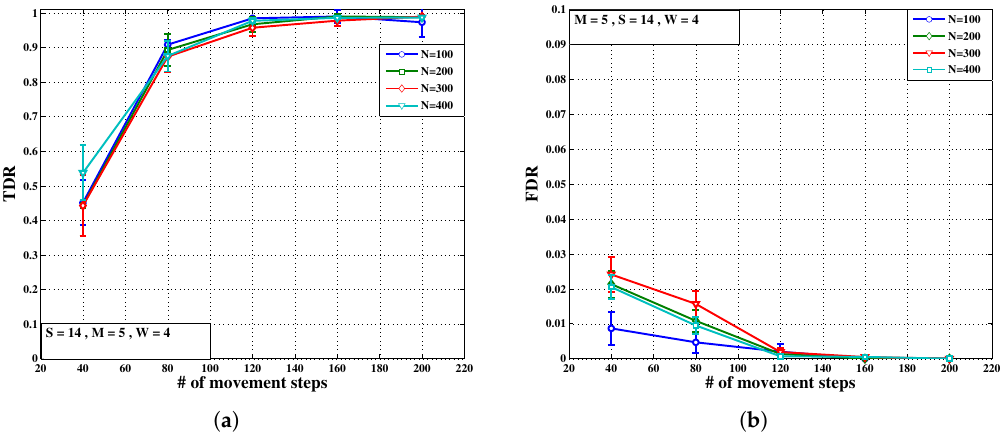
Figure 8. Variation of TDR ( a ) and FDR ( b ) versus time for different normal node